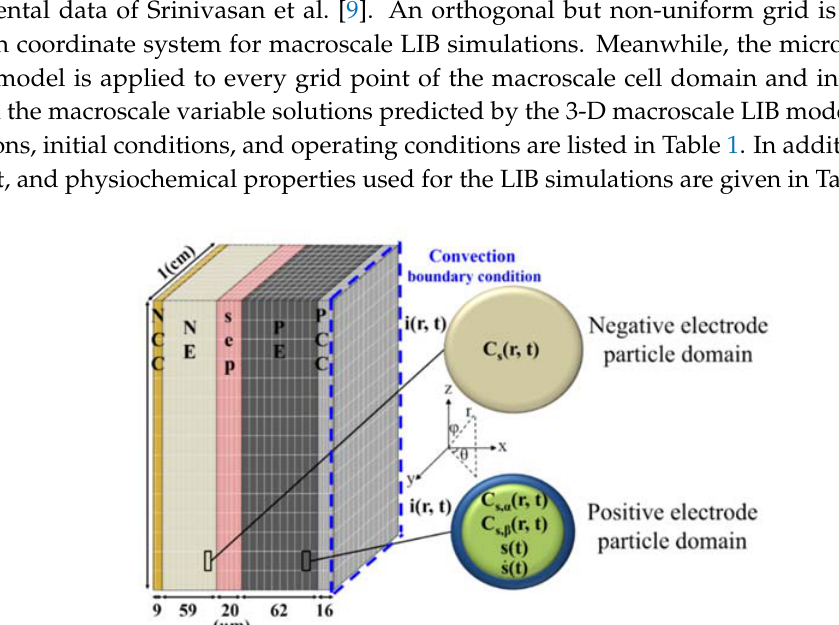
Figure 2. Micro ‐ and macro ‐ scale computational domains of a LIB cell and the coupling variables exchanged during multiscale simulations.